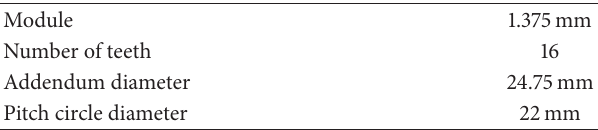
Table 5: Sun gear specification.